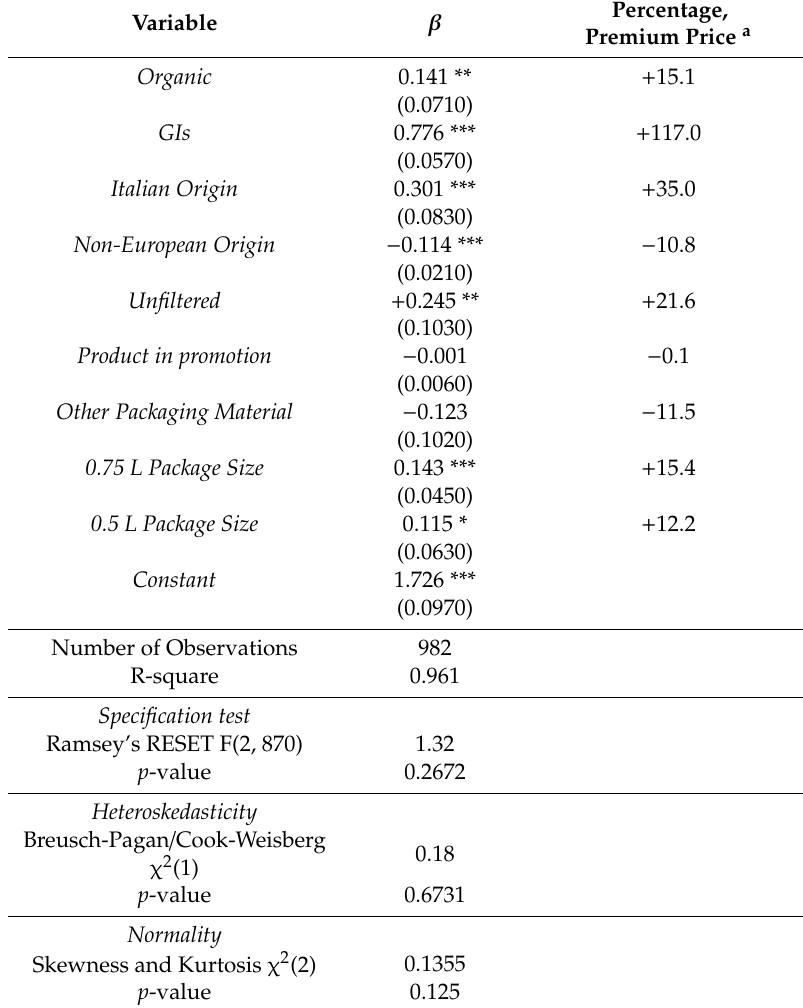
Table 2. Estimated parameters and percentage of premium